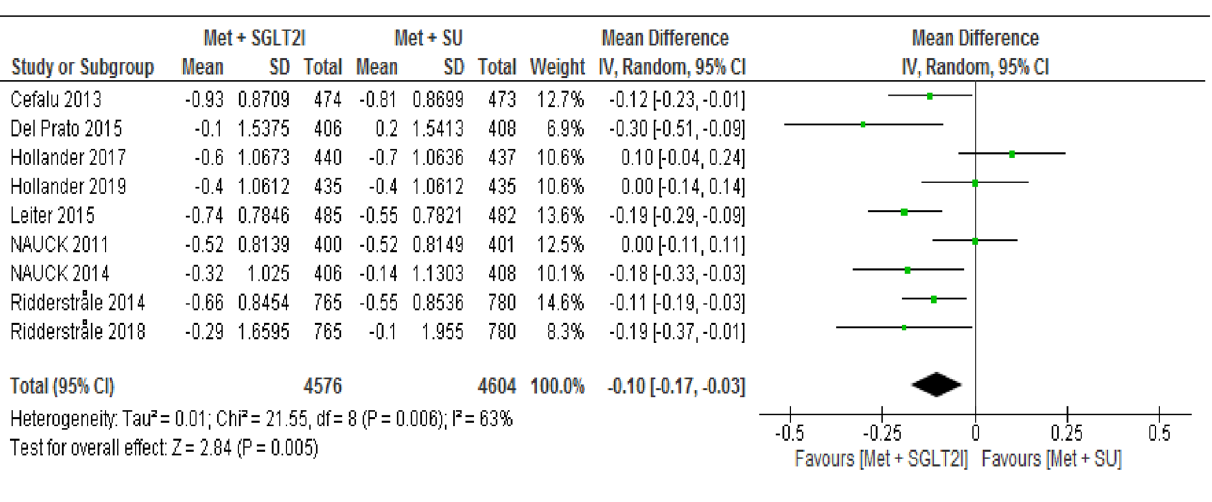
Figure 8. Risk of hypoglycemia between patients who were on metformin-SGIT2I and metformin- sulphonylureas combination therapies. RR risk ratio; CI confidence interval; df degrees of freedom; Met metformin; SGLT2I sodium-glucose co-transporter 2 inhibitor; SU sulfonylurea.